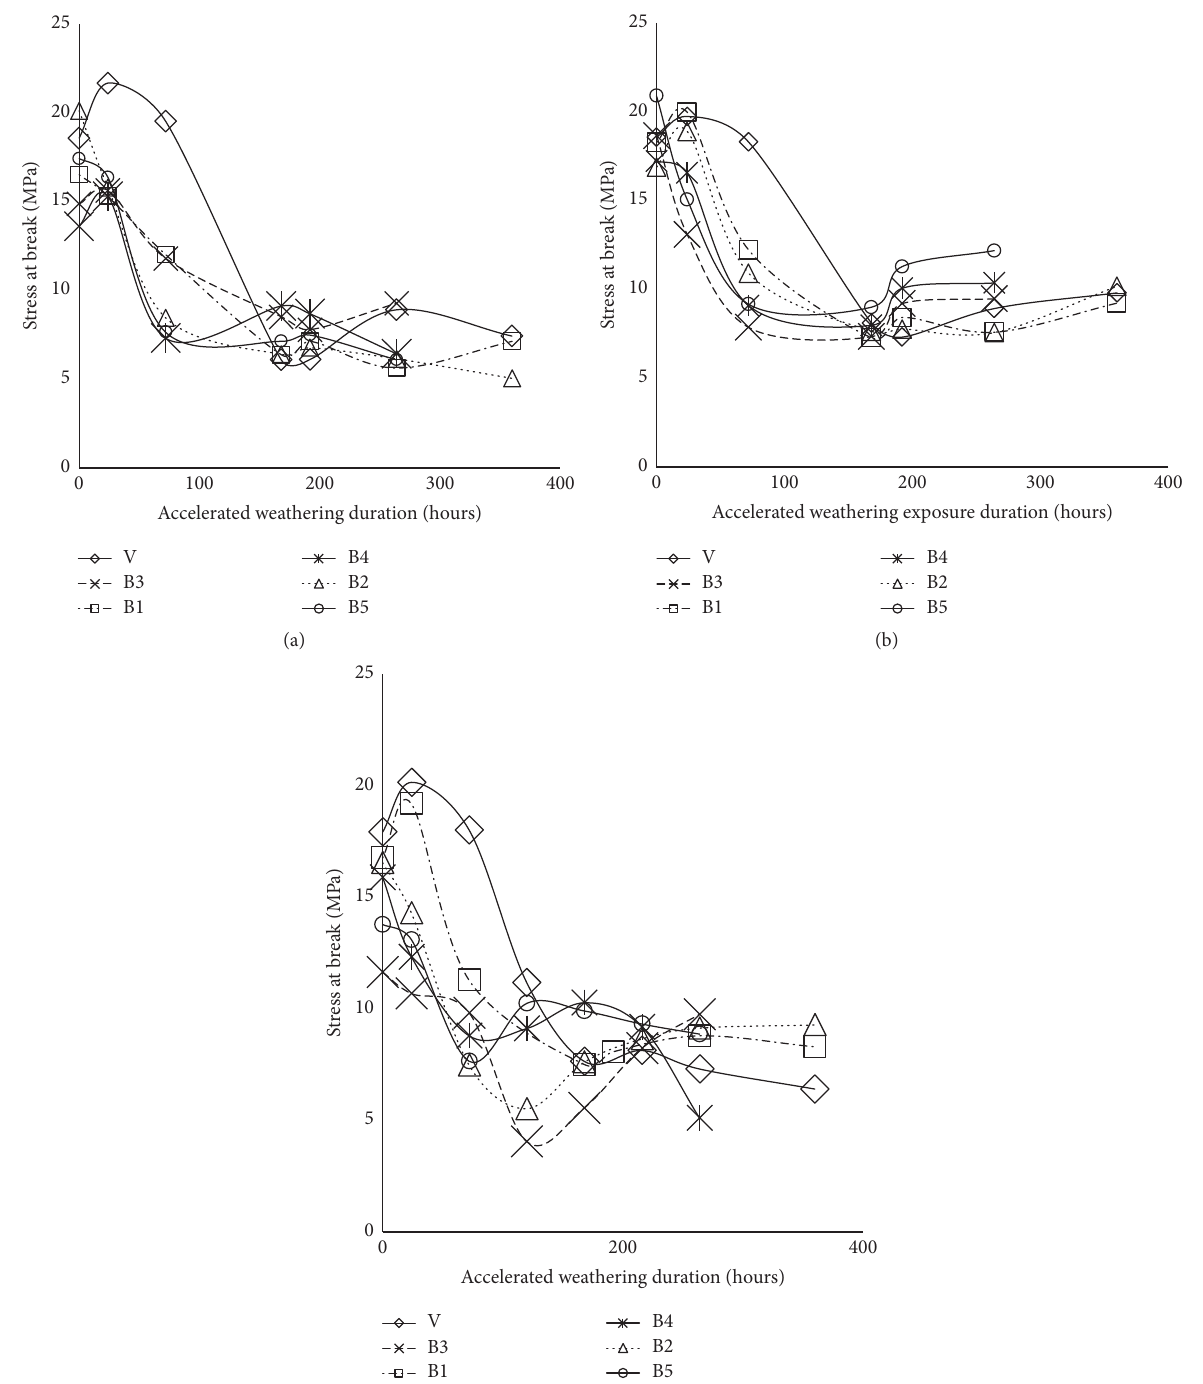
Figure 5: Stress at break for studied blends formulated using Die Head Temperature (DHT) equal to 175 ∘ C (a), 185 ∘ C (b), and 195 ∘ C (c).